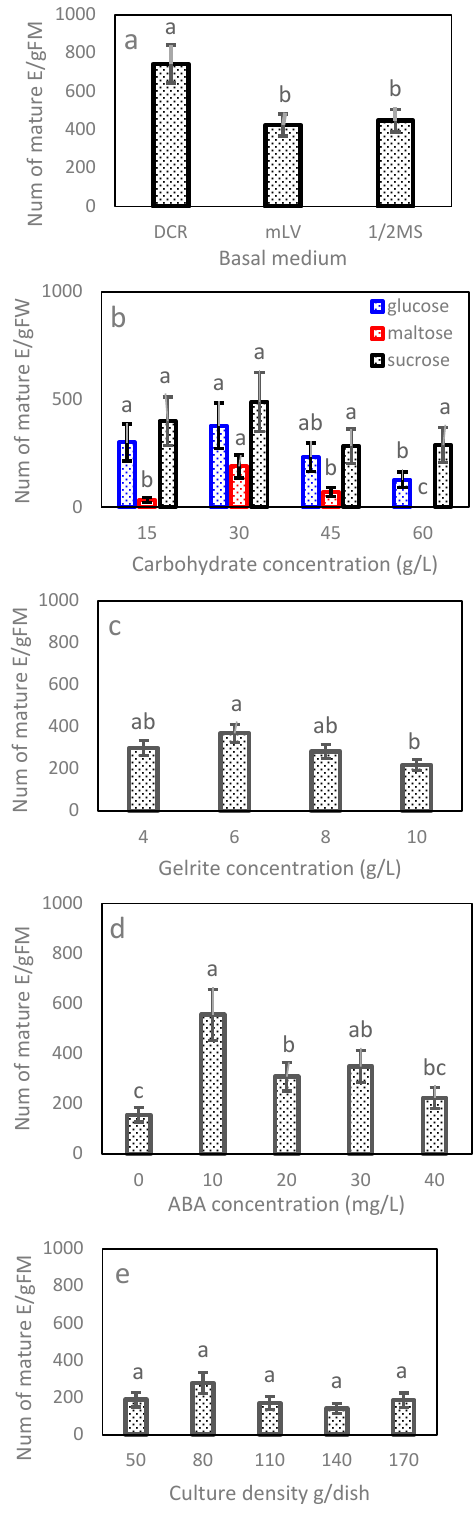
Figure 4. Maturation frequency and standard error by experiment: ( a ) basal medium, ( b ) carbohy- drate type and concentration, ( c ) Gelrite, ( d ) ABA and ( e ) culture density. Values with the same letters marked on a panel were insignificant other than ( b ), of which values with the same letters marked within a carbohydrate type were insignificant. Note that E/gFM represents embryos obtained from per gram fresh weight tissues